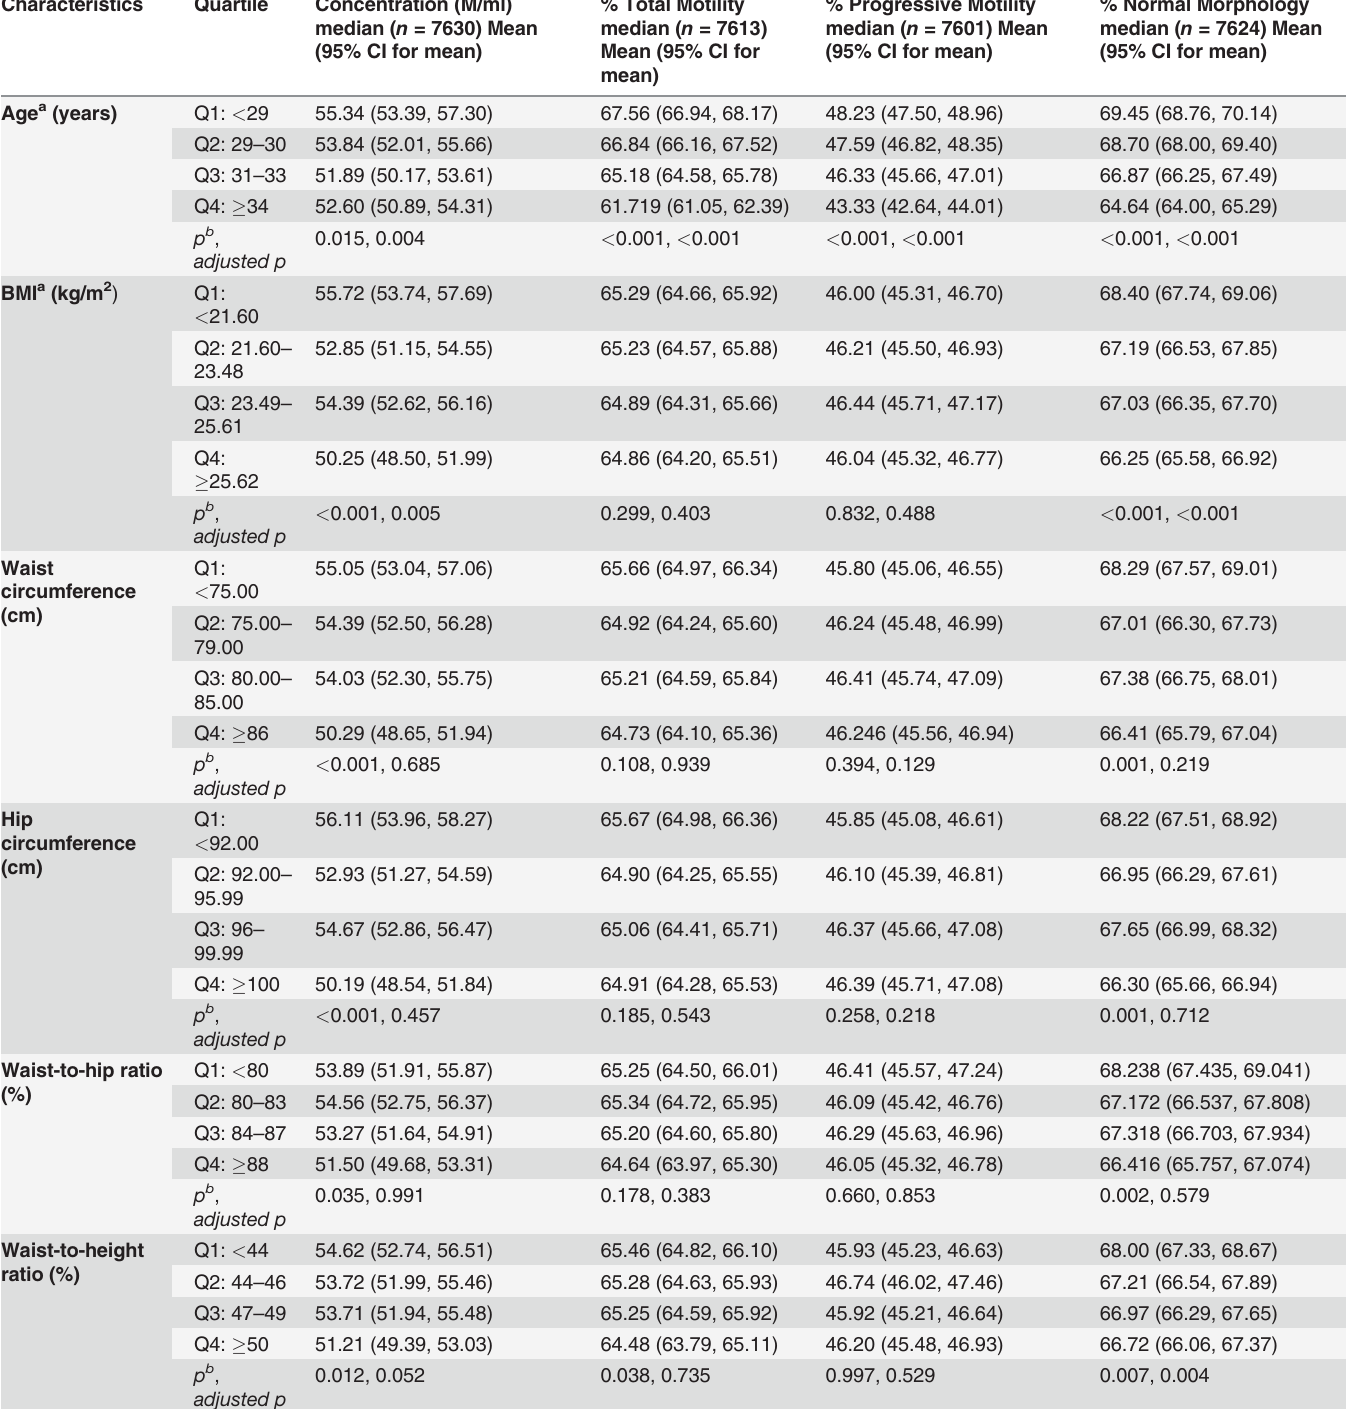
Table 2. Age and anthropometric indexes by semen parameters.